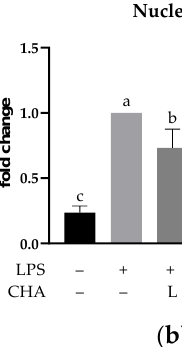
8 of 14 Figure 5. Effect of different delivery models on the phosphorylation levels of MAPK. Cells were treated with LPS (100 ng/mL) and CHA for 2 h. ( a ) Representative images of phosphorylated p38, total p38, phosphorylated ERK, and total ERK. ( b ) Quantification of the proportion of phosphory- lated p38 and total p38 and phosphorylated ERK and total ERK. Bars without a common letter in- dicate significant differences ( p < 0.05). CHA: chlorogenic acid; LPS: lipopolysaccharide; ERK: extra- cellular signal-regulated kinase; L: low dose administered via pipette; LS: low dose administered